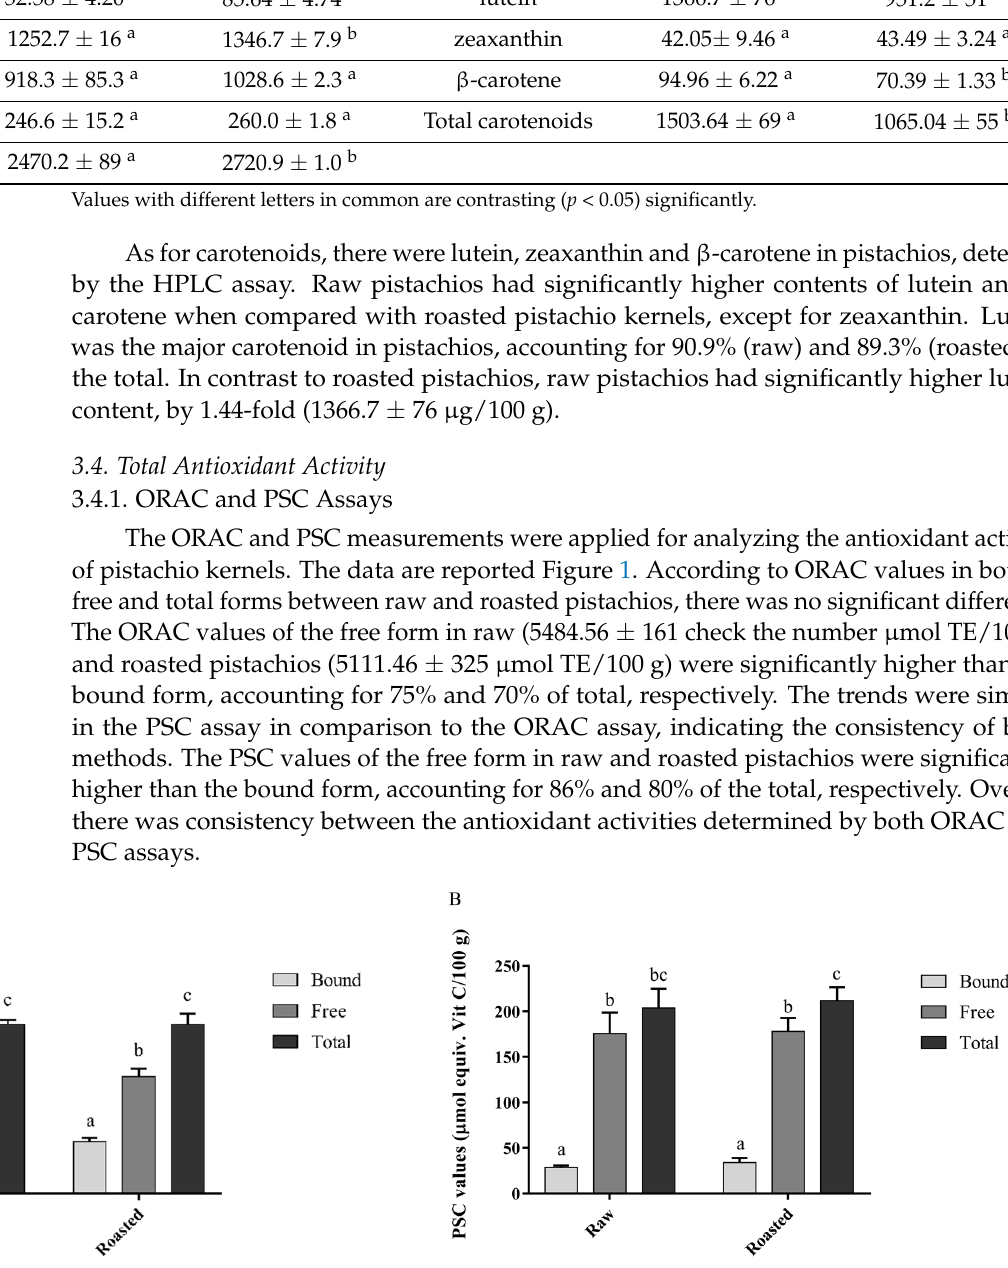
Table 3. Vitamin E and carotenoids profiles of pistachios (raw and roasted) (independent T-test).